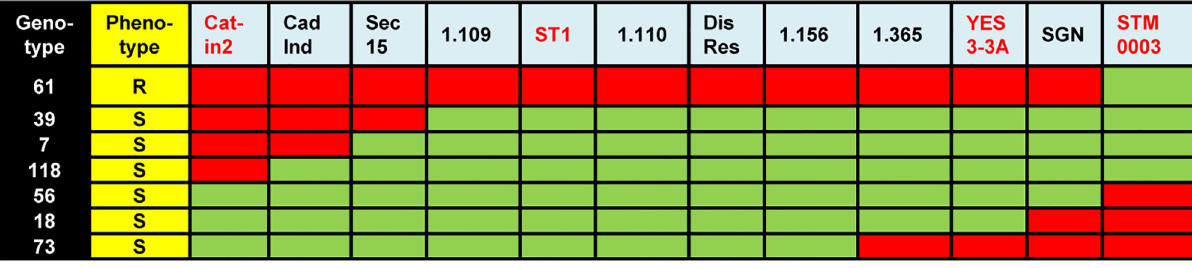
Fig 1. Colourmap of the Ry region. R, resistant; S, sensitive. The presence of markers representing the resistant parent ‘White Lady’ are indicated by sto red boxes, while the presence of markers representing the sensitive parent ‘S440’ are indicated by green boxes in seven genotypes of the F1 population. Published markers are